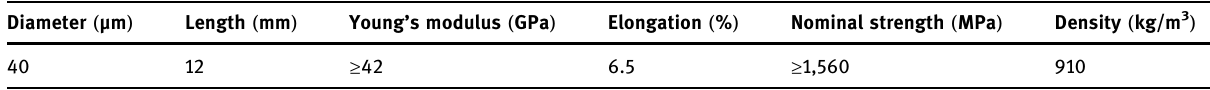
Table 3: Properties of PVA fi ber Diameter ( μ m